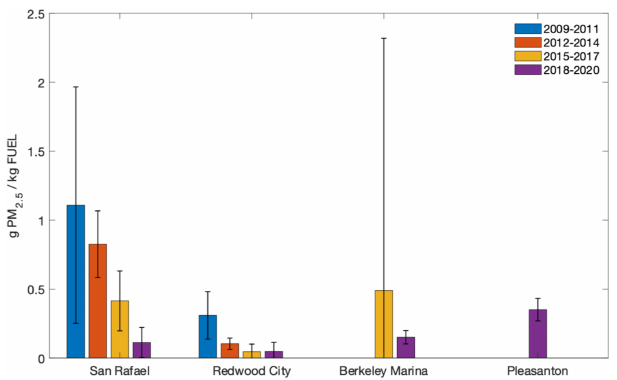
Figure 4. Fleet emission factors, derived from all sites, for all years, and binned by truck fraction are shown at the top. The HDV